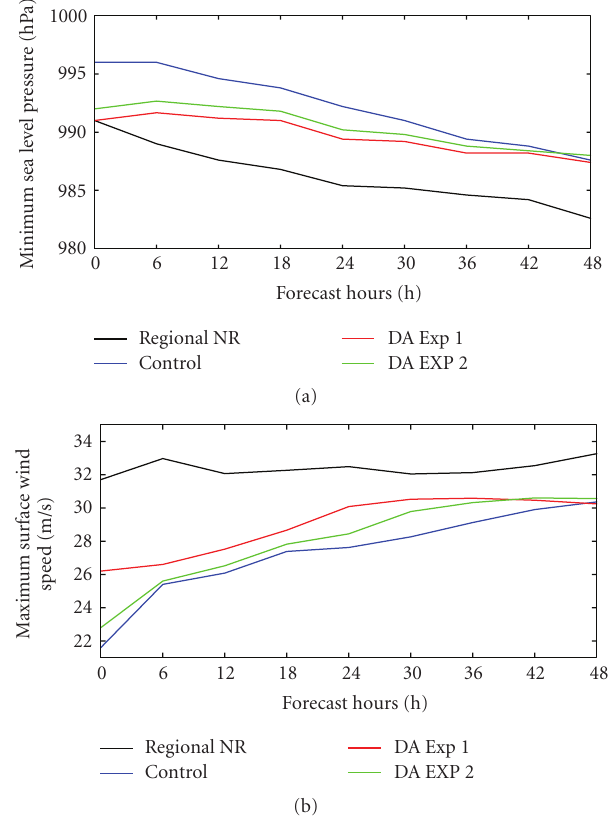
Figure 7: Time series of (a) minimum Sea Level Pressure (SLP) at the storm center and (b) maximum surface wind speed from di ff erent experiments (black line: regional nature run; blue line: control run; red line: data assimilation Experiment 1; green line: data assimilation Experiment 2) from 0600 UTC 01 to 0600 UTC 03 October